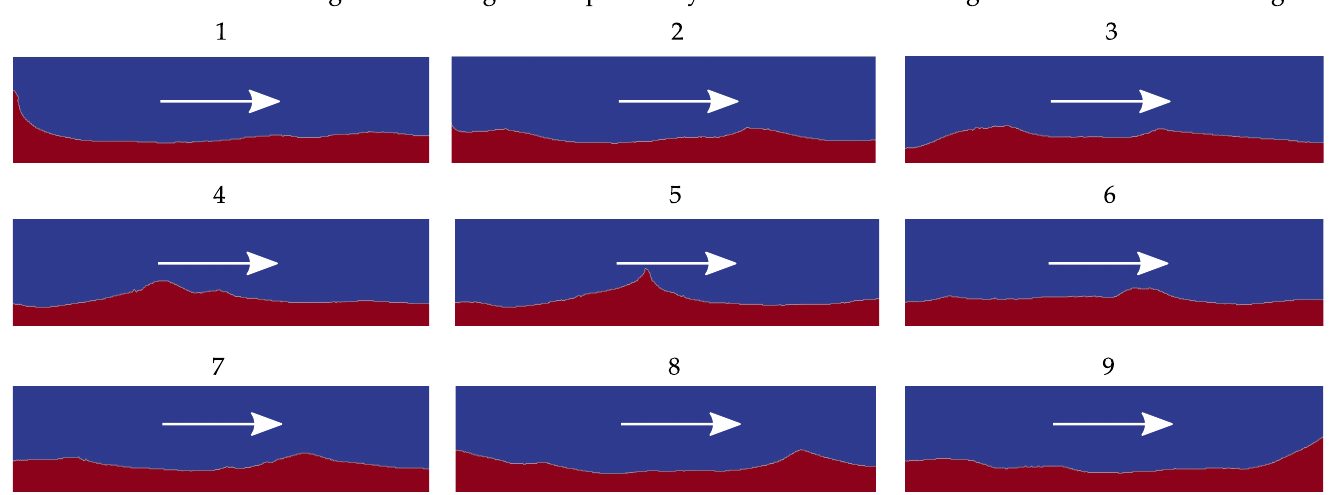
Figure 5. Showcasing the representative setup and qualitative results for the imposed motion of a = 5mm and h 0 = 40mm: the water surface being best identified by the border between the densities of air and